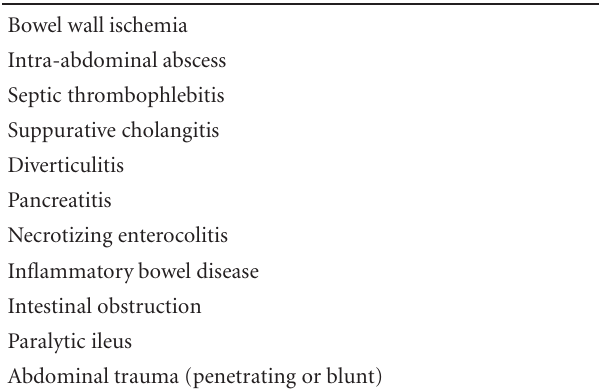
Table 1: Important causes of hepatic portal venous gas in critically ill patients.